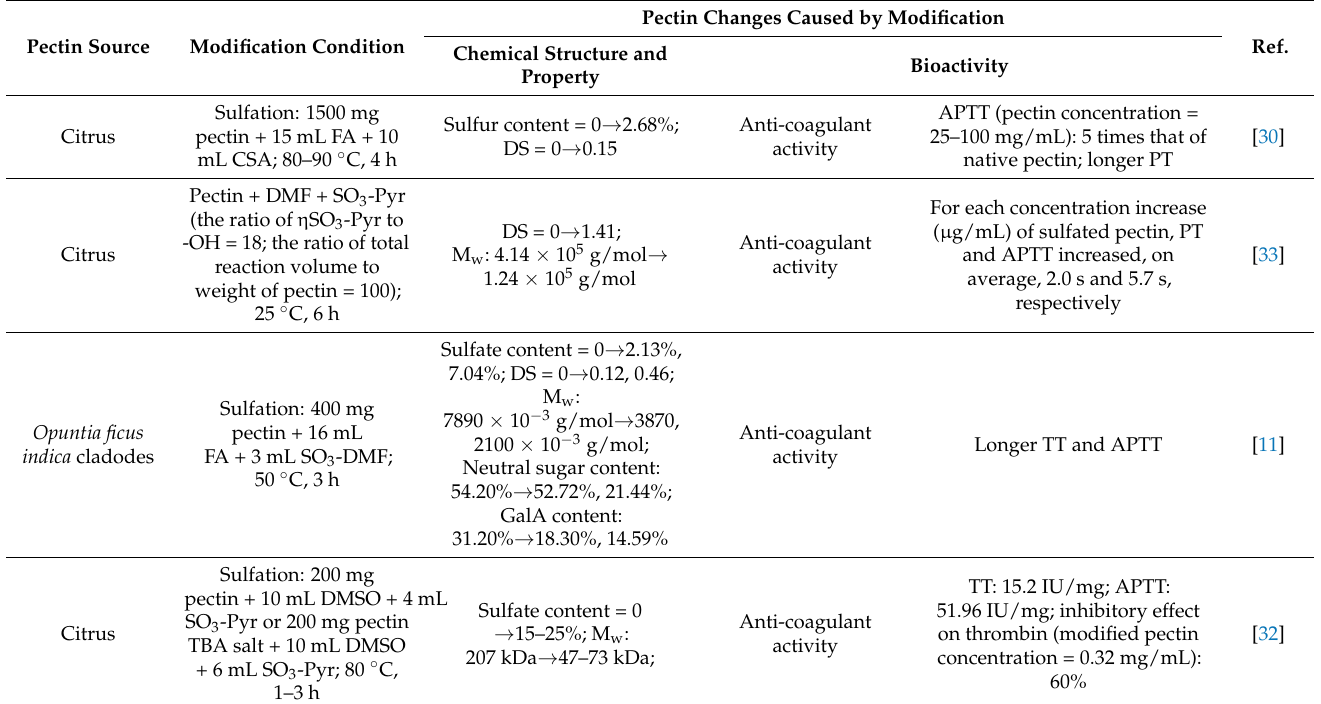
Table 3. A summary of the differences between modified pectin and natural